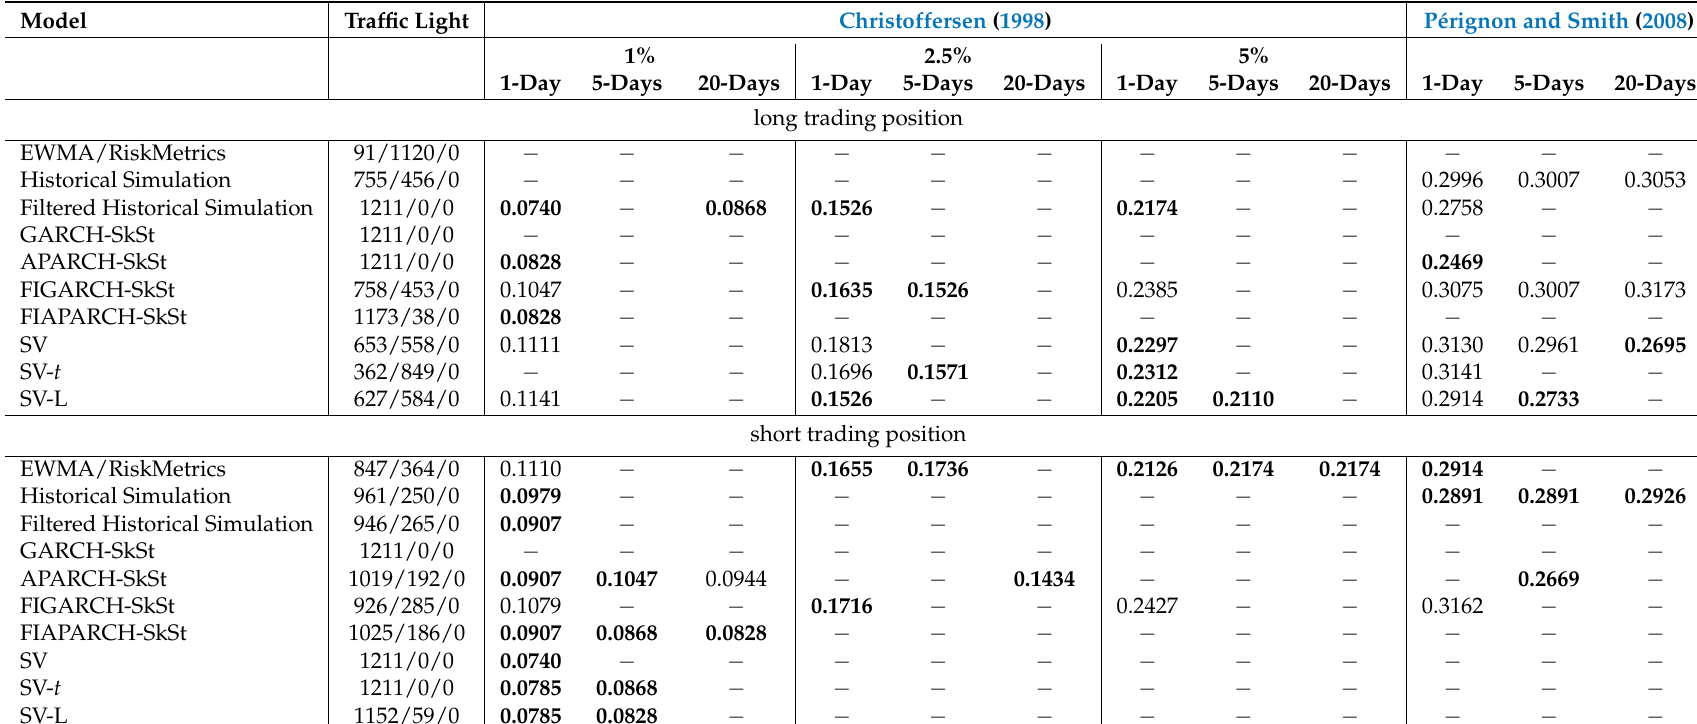
Table 2. Value-at-Risk backtest results for JCI